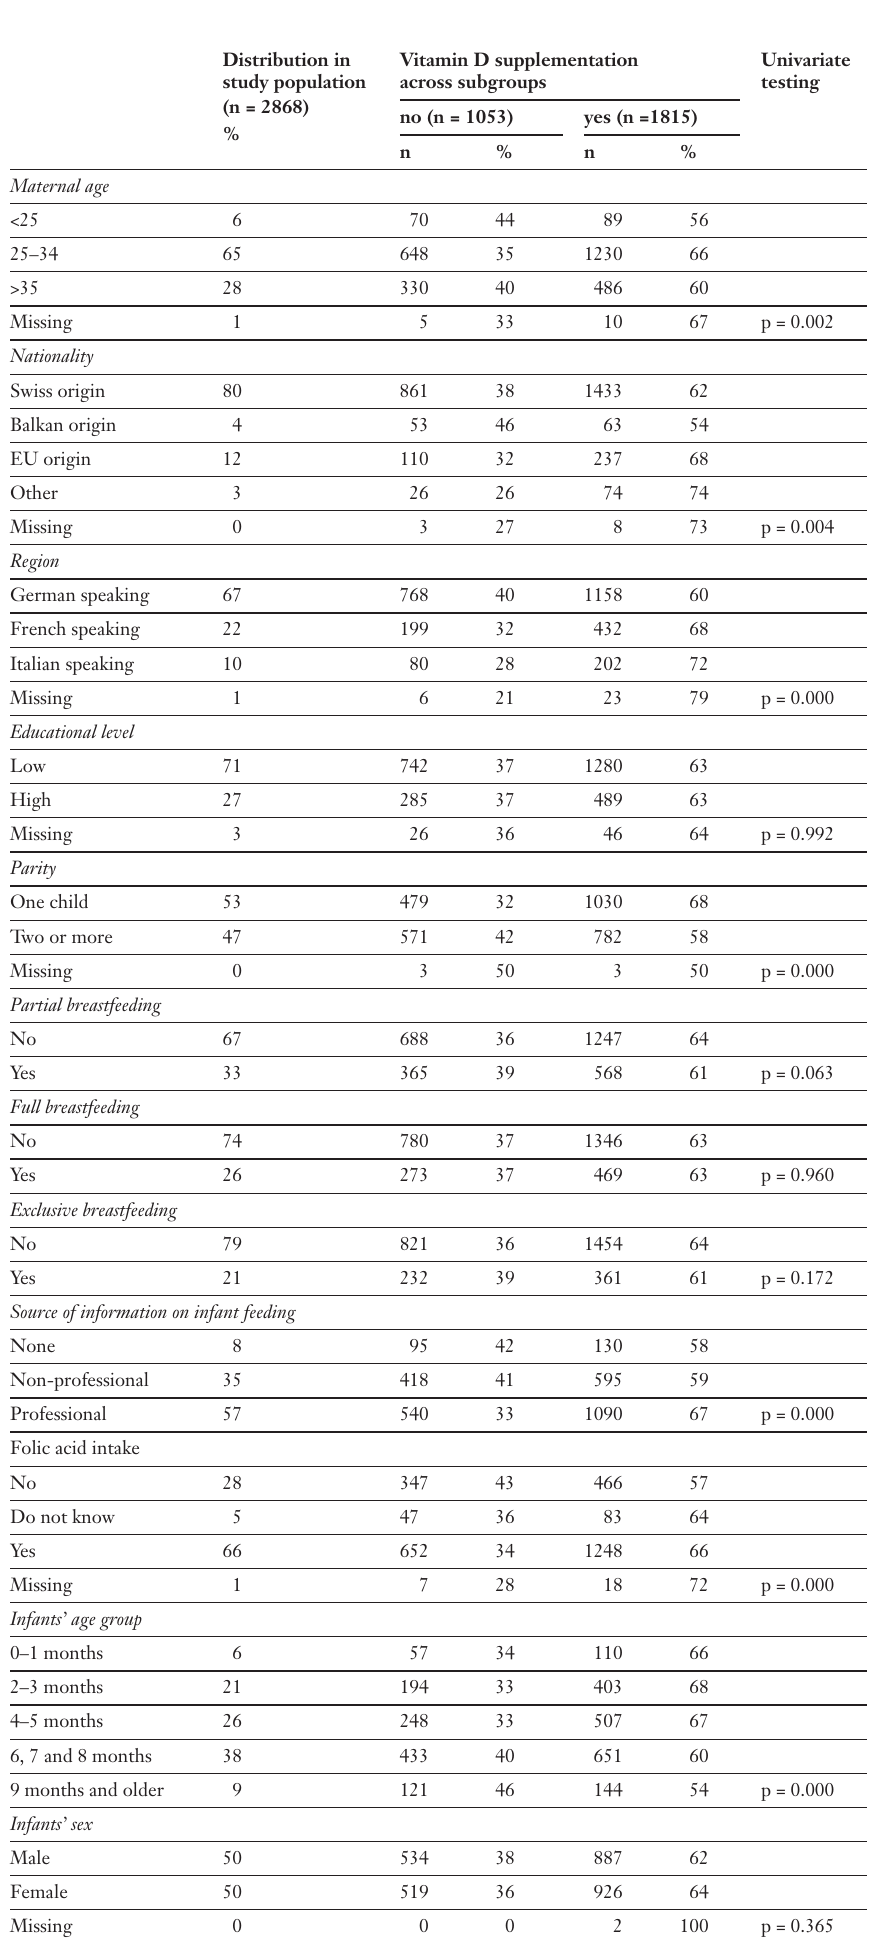
Table 1 Prevalence of vitamin D supplementation across subgroups (n =